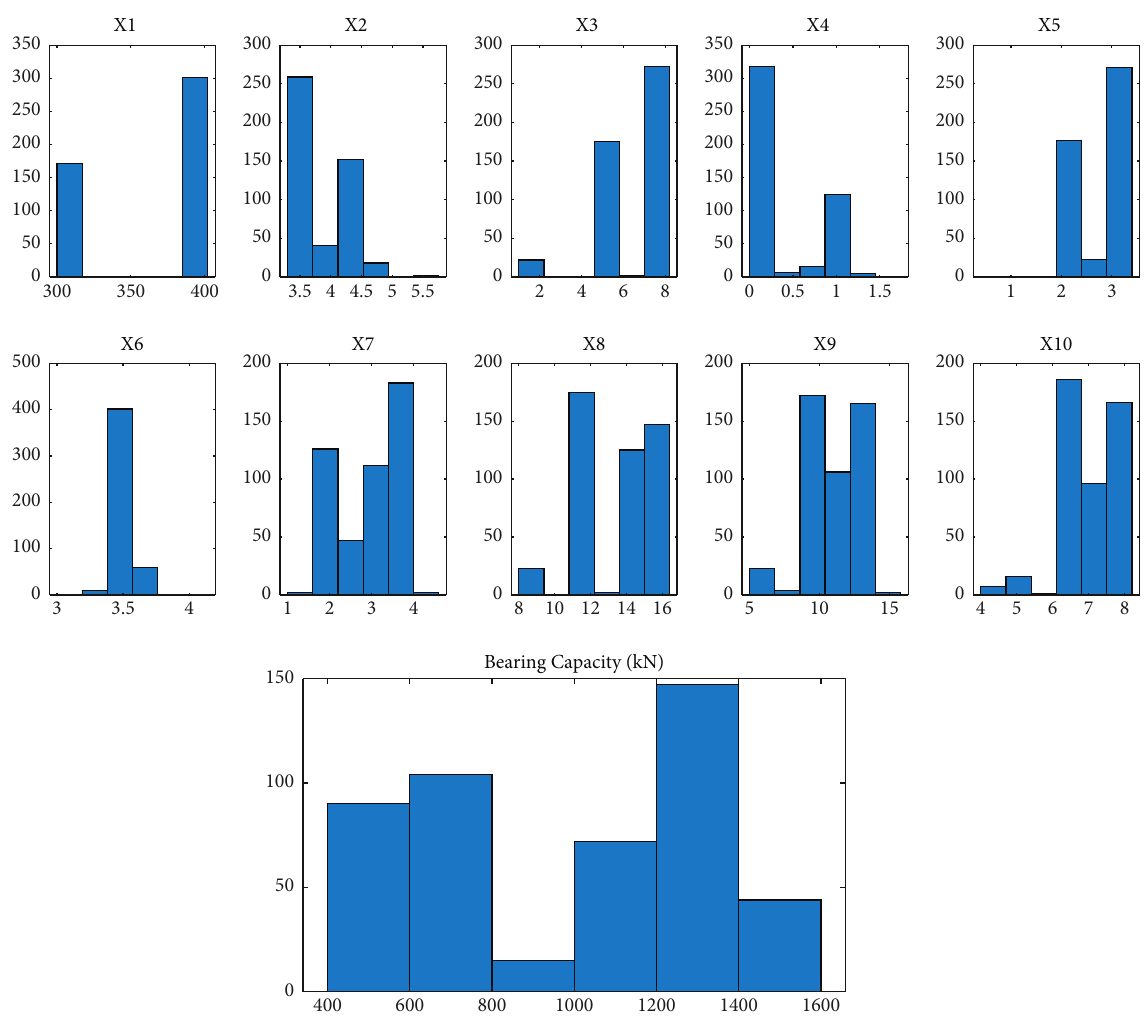
Figure 3: Histograms of influencing factors X 1, X 2, .. . , X 10 and pile bearing capacity Y . Table 1: Statistical descriptions of the influencing factors and pile bearing